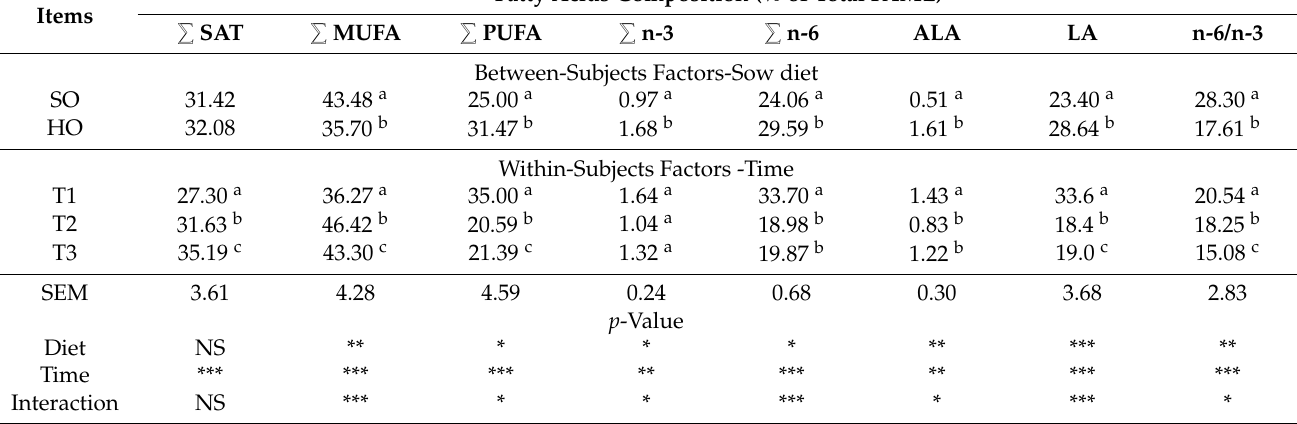
Table 4. FAs composition of milk from sows fed a classical diet based on soybean oil (SO) or a rich n-3 Table 1. Ingredients and nutrient composition for Topigs-40 hybrid primiparous sows and their offspring ’s FA and lower n-6:n-3 ratio diet based on hemp seed oil (HO) at different time points after farrowing (12 h, 10 days, and 21 days). Fatty Acids Composition (% of Total FAME)